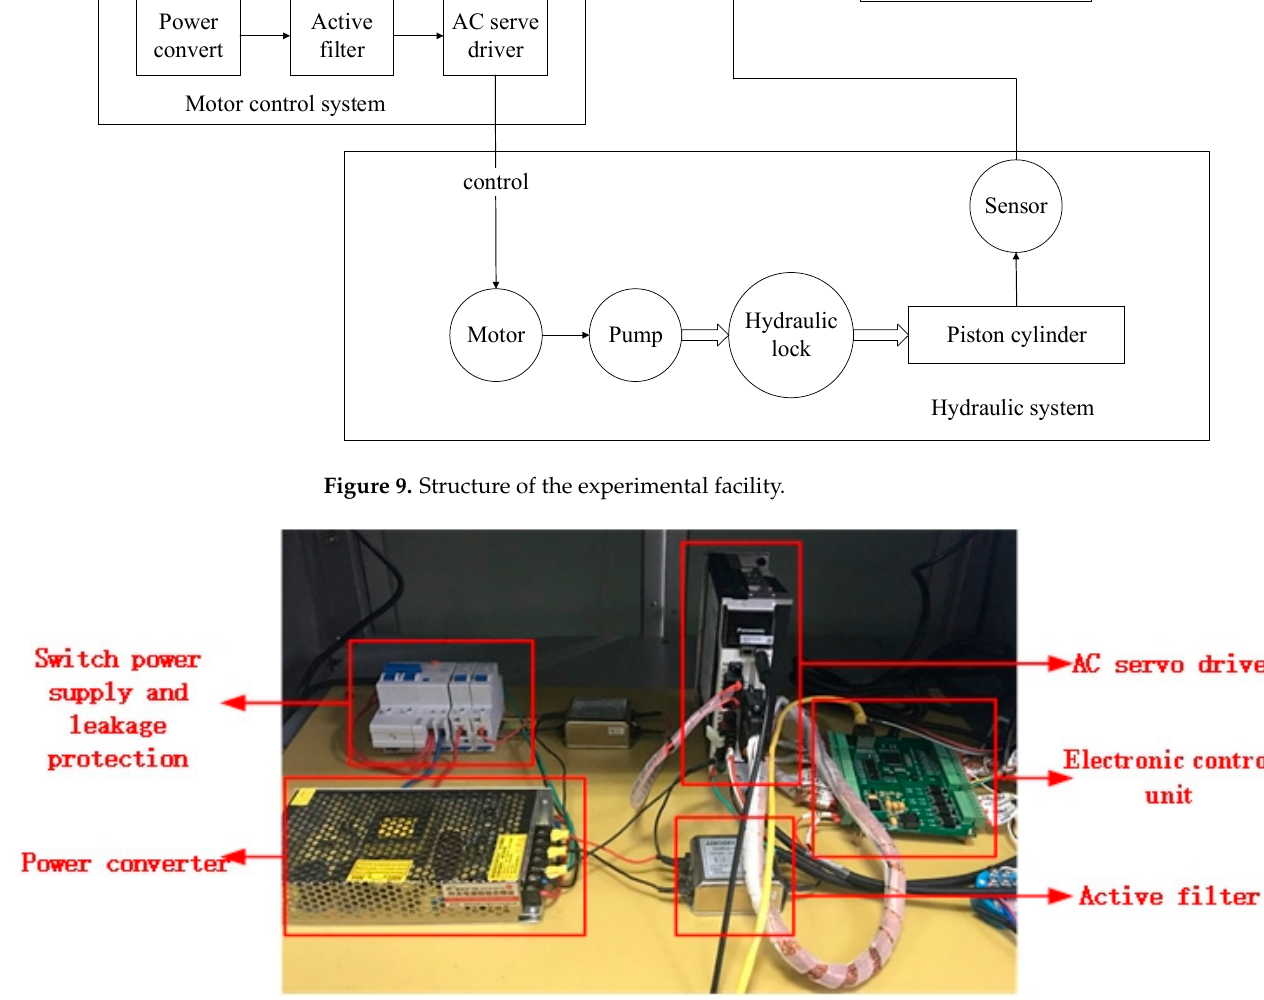
Figure 10. Structure of the motor control system facility.